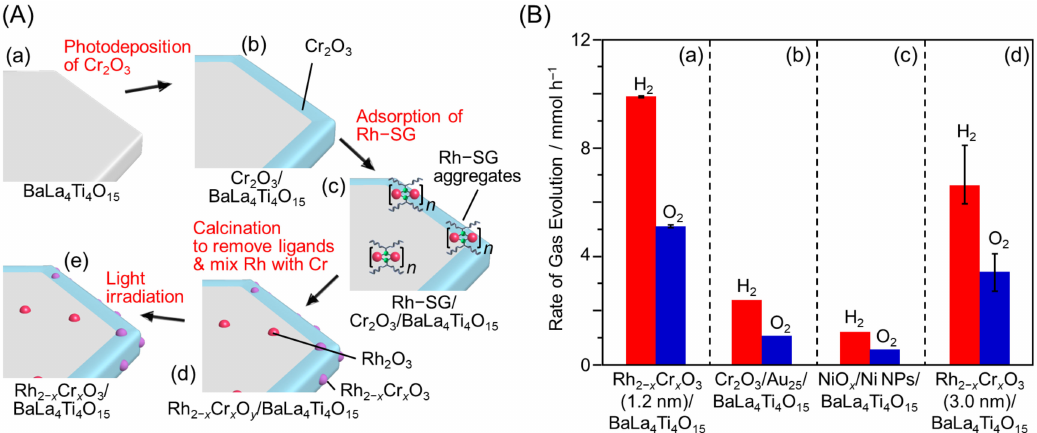
Figure 19. ( A ) Schematic of experimental procedure for the formation of BaLa 4 Ti 4 O 15 loaded with small Rh 2 − x Cr x O 3 NCs (1.2 nm) cocatalysts (Rh 2 − x Cr x O 3 (1.2 nm)/BaLa 4 Ti 4 O 15 ). ( a ) BaLa 4 Ti 4 O 15 , ( b ) Cr 2 O 3 /BaLa 4 Ti 4 O 15 , ( c ) Rh–SG/Cr 2 O 3 /BaLa 4 Ti 4 O 15 , ( d ) Rh 2 − x Cr x O y (1.2 nm)/BaLa 4 Ti 4 O 15 , and ( e ) Rh 2 − x Cr x O 3 (1.2 nm)/BaLa 4 Ti 4 O 15 . Rh 2 − x Cr x O y represents Rh 2 − x Cr x O 3 containing highly oxi- dized Cr (> 3+). ( B ) Comparison of H 2 and O 2 evolution rates from pure water using a high-pressure Hg lamp (400 W) over different photocatalysts: ( a ) Rh 2 − x Cr x O 3 (1.2 nm)/BaLa 4 Ti 4 O 15 (0.09 wt%